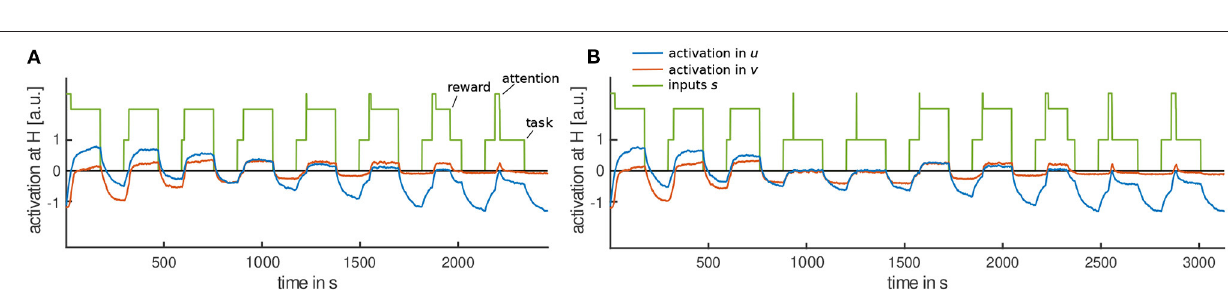
FIGURE 9 | Exemplary time courses of activation until habituation criterion is met: (A) With reward input applied on all trials, the habituation criterion is met on the eighth trial. (B) When reward input is omitted in trials four to six, the habituation criterion is met on the tenth